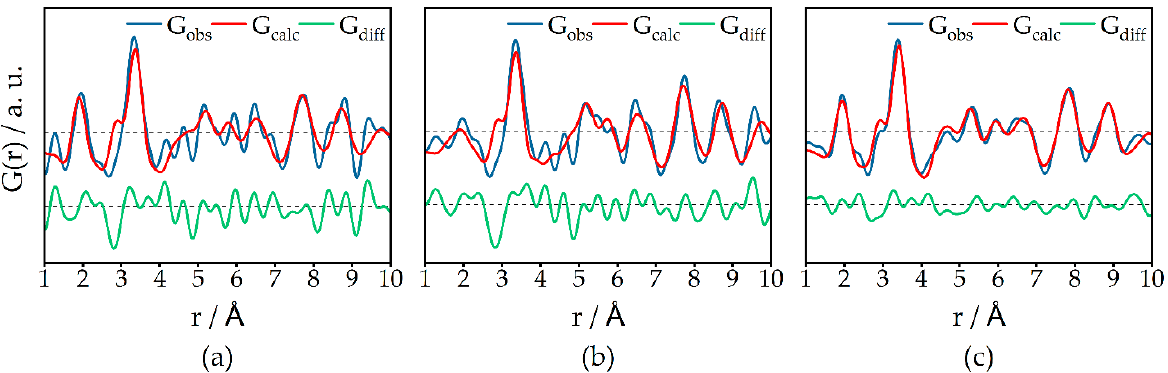
Figure 4. d-PDF refinements of Fe05 ( a ), Fe10 ( b ), and Fe20 ( c ) in the 1–10 Å regime using laboratory PDF data. Dashed lines indicate the zero line of the respective refinement. Higher loadings show less noise. The two highest peaks for the Fe-O and Fe-Fe interatomic distances at 1.95 and 3.41 Å are quite well resolved for every loading; G(r) = reduced pair distribution function; R w (Fe05) = 0.51; R w (Fe10) = 0.50; R w (Fe20) = 0.26.